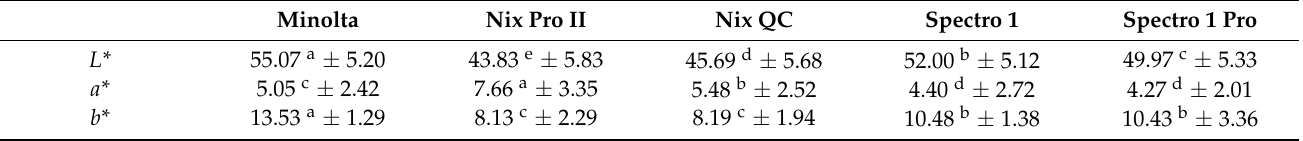
Table 3. Descriptive statistics of mean colour coordinate value of retail meat samples for each instrument and